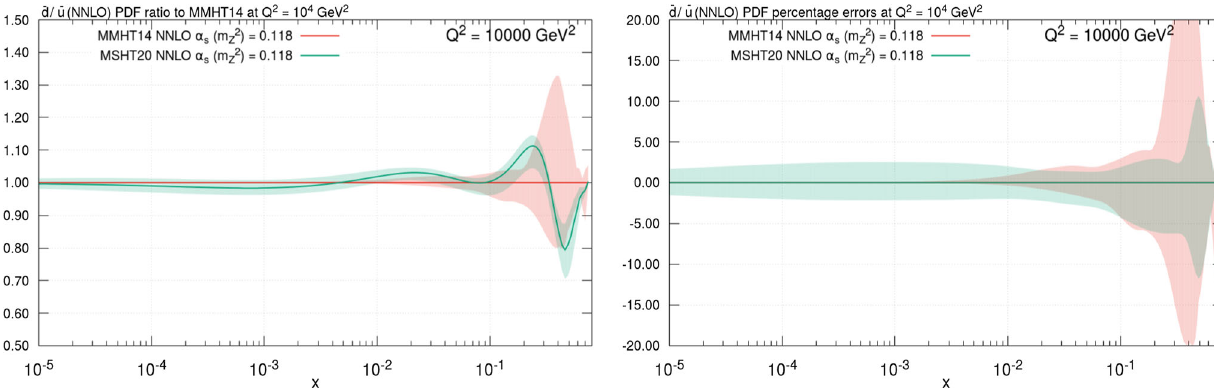
Fig. 26 ¯ d / ¯ u PDFs, for MSHT20 and MMHT14 at NNLO and Q 2 = 10 4 GeV 2 . (Left) ratio to MMHT14. (Right) percentage